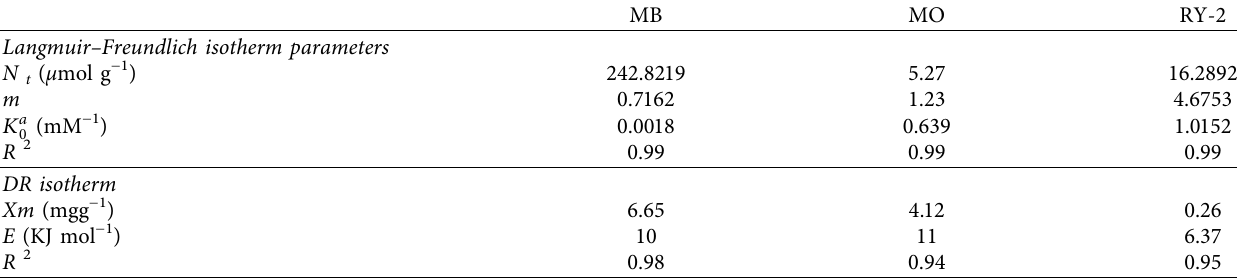
Table 4: Values of fitting parameters obtained from LF and DR isotherms.